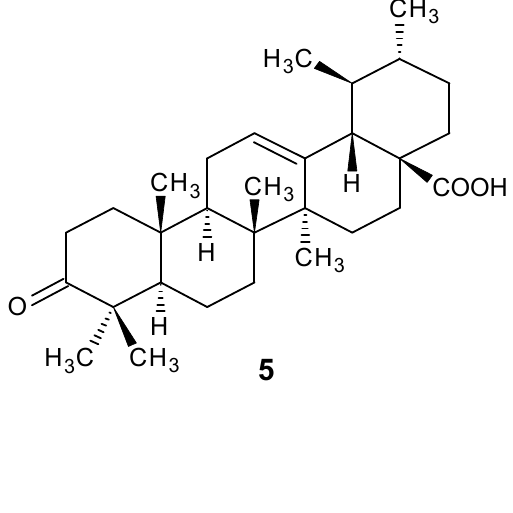
Figure 2. Chemical structure of 3-oxourosolic